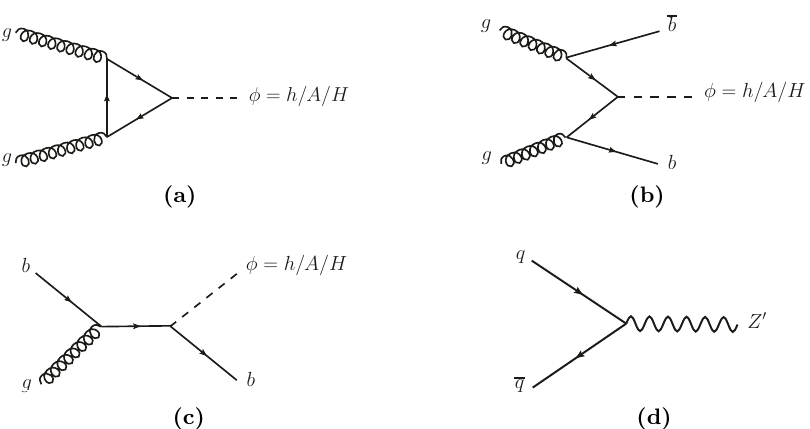
Figure 1. Lowest-order Feynman diagrams for (a) gluon-gluon fusion and b -associated production of a neutral MSSM Higgs boson in the (b) four-(cid:13)avour and (c) (cid:12)ve-(cid:13)avour schemes and (d) Drell-Yan production of a Z 0